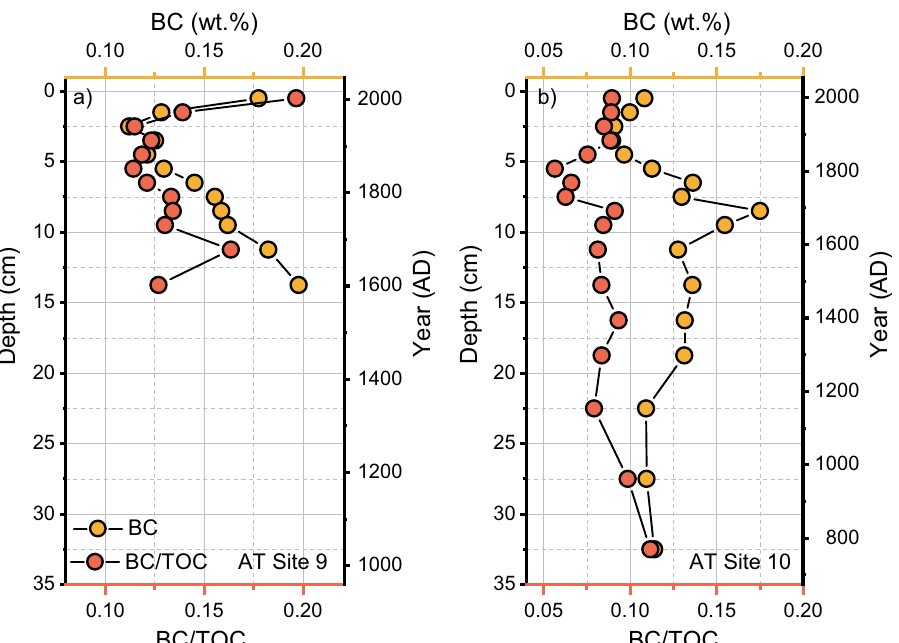
Fig. 7 Depth (Age) pro fi les of the Black carbon (BC) content and BC over total organic carbon (TOC) ratio in two sediment cores in the Atacama Trench (AT). a non-hadal site A9. b adjacent hadal site